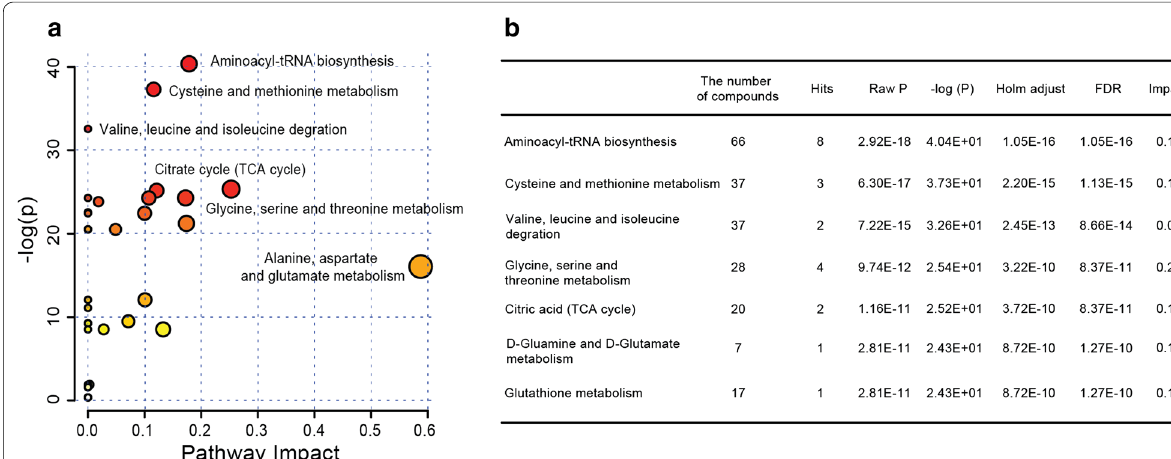
Fig. 5 Metabolic pathway ( a ) generated using MetaboAnalyst to identify the most relevant pathways from metabolites identified in fermented tomato samples between LF , BL , and PP versus LB . The color and size of the circles indicate significant changes in metabolites and the impact score in the metabolic pathways, respectively. Panel ( b ) shows statistics for major changed pathways, based on p value and false discovery rate. LF Lactobacillus fermentum , BL Bifidobacterium longum , PP Pediococcus pentosaceus , LB Lactobacillus